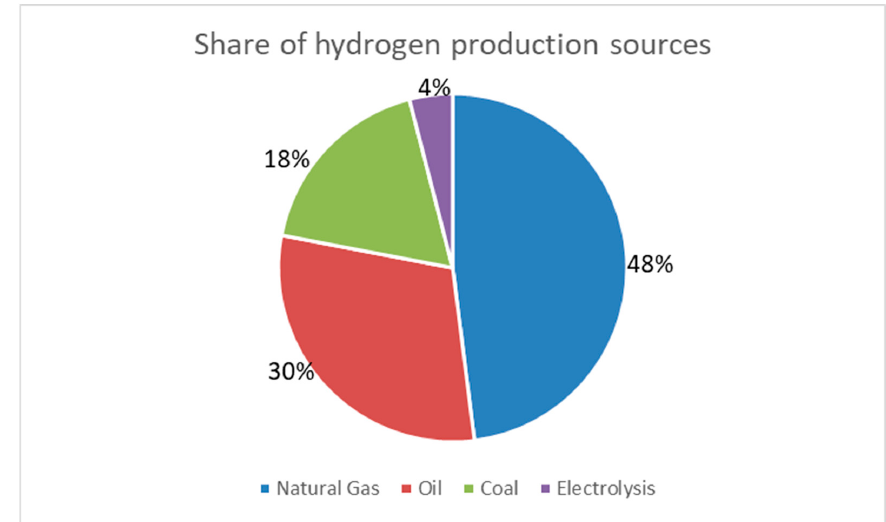
Figure 13. Share of hydrogen production sources.